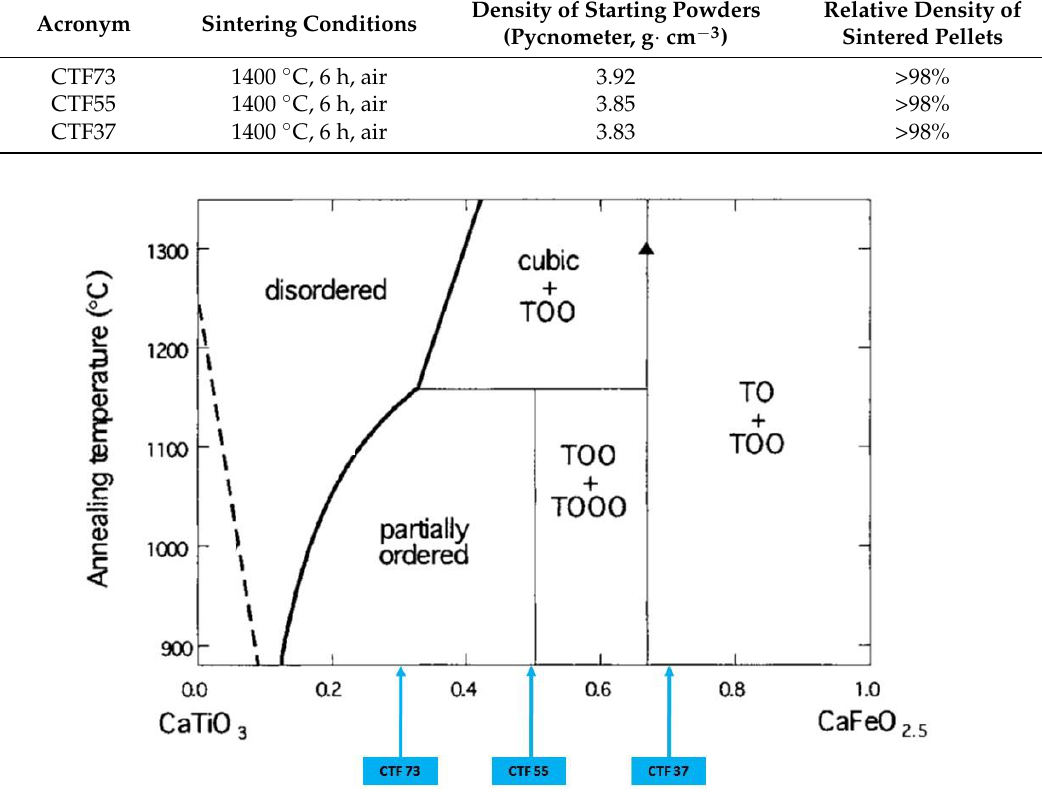
Figure 1. Phase diagram of the CaTiO 3 — CaFeO 2.5 system with the three oxides explored in this study: CaTi 0.7 Fe 0.3 O 3−δ (CTF73), CaTi 0.5 Fe 0.5 O 3−δ (CTF55), and CaTi 0.3 Fe 0.7 O 3−δ (CTF37). The symbols TO, TOO, and TOOO correspond to the sequence of layers of tetrahedra and octahedra in the ordered structures. Reproduced with permission from [12]. Table 1. Dense CaTi 1−y Fe y O 3−δ Perovskite Pellets Sintering Conditions.